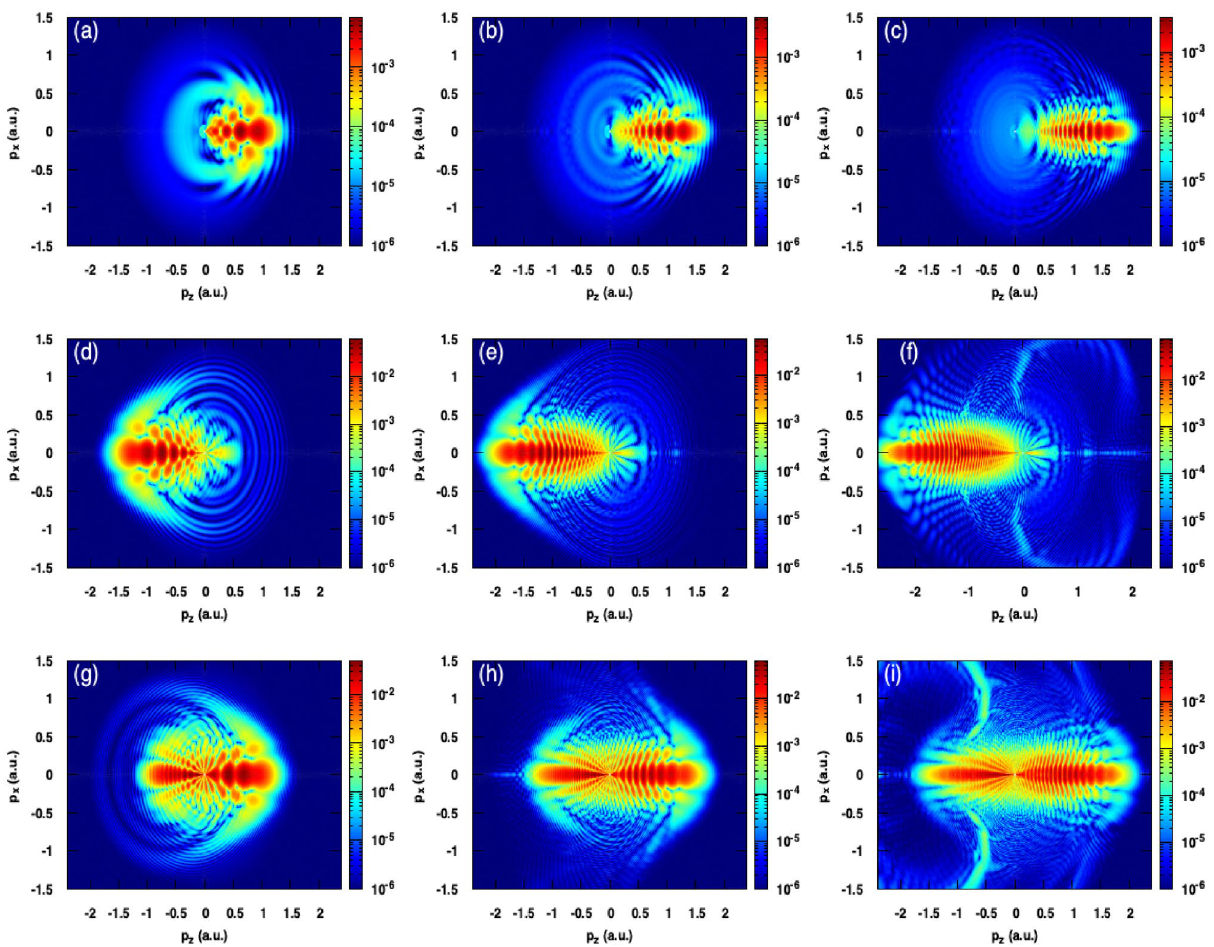
Figure 8. Photoelectron momentum distributions for three laser wavelengths with peak intensity and carrier envelope phase fixed respectively at 100 TW/cm 2 and ϕ cep . Panels of the first, second and third column correspond respectively to the wavelengths (cid:31) = 800, 1200 and 1600 nm. ( a , b , c ) N = 1; ( d , e , f ) N = 2; ( g , h , i ) N